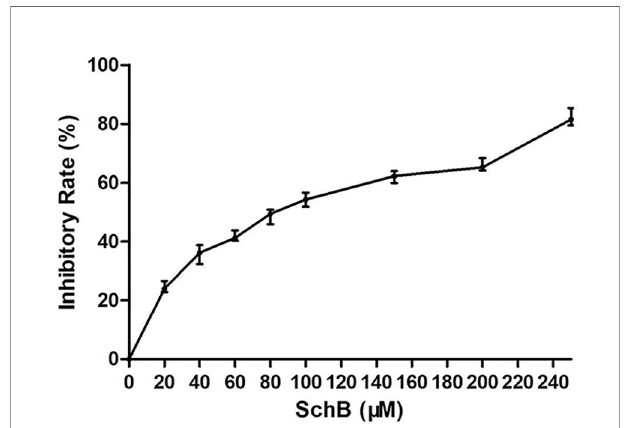
FIGURE 1 | Sch B inhibits proliferation in Hepa1-6 cells. Proliferation curve of Hepa1-6 cells treated with